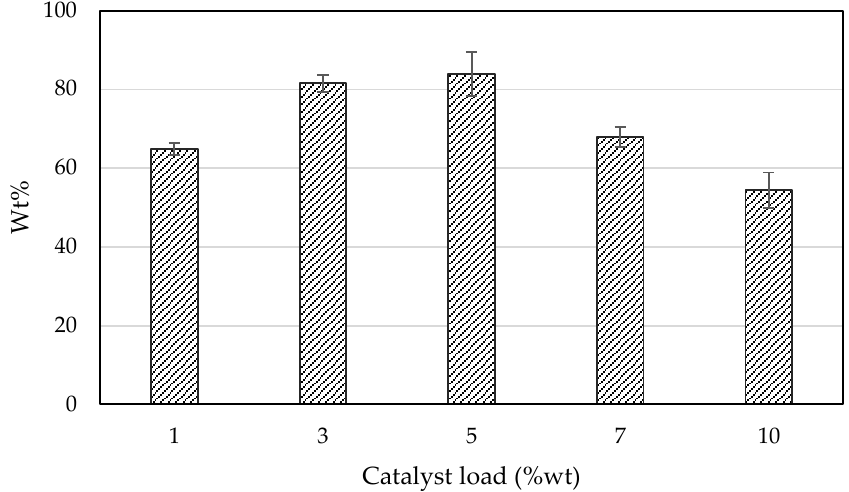
Figure 7. Effect of catalyst loading with KOH-impregnated eggshell (20%) on the biodiesel yield using methanol to oil molar ratio of 15:1 at 60 °C for 60 min. The p -values of ANOVA test was 0.000 ( p < 0.05).